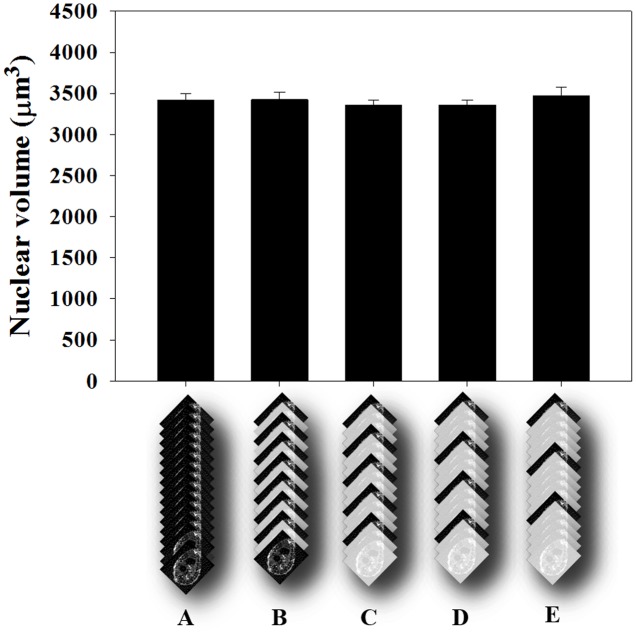
Average volume estimation of nuclei in GC of Arabidopsis roots. (A) Confocal optical sections covering 60 μm depth were measured using the ImageJ plug-in, Volumest. The z-stack contained 130 images where each nuclei volume was recorded. (A) Result obtained for each section measured. (B) Measuring one and skipping the next section. (C) Measuring one and skipping every two next sections. (D) Measuring one and skipping the next three sections. (E) Measuring one and skipping the next four sections. No statistical difference was detected after ANOVA test (p > 0.05). Subsequent measurements were then performed like in D.